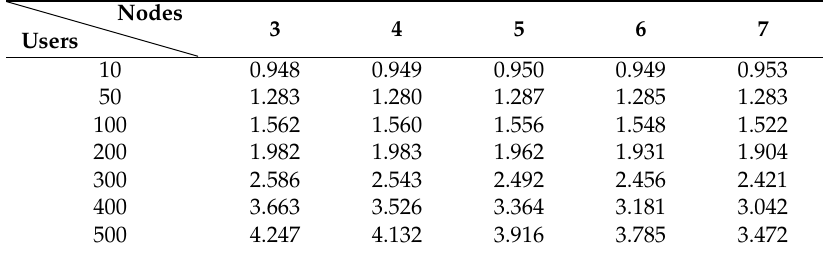
Table 3. Response time of a complex query with multiple nodes by concurrent